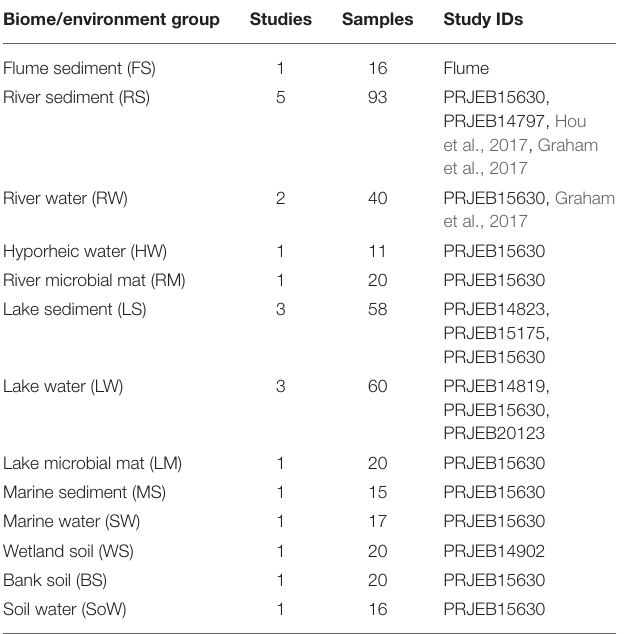
TABLE 1 | Number of samples and studies representing the different environments selected in this study. Biome/environment group